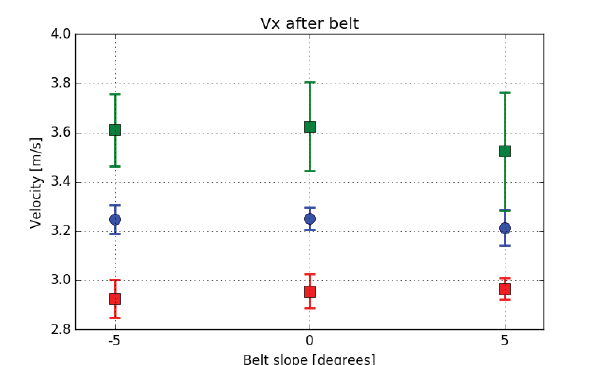
Figure 5. Results for inclining the belt. Here we show the mean values for V x maximum (upper squares), mean (discs), and min- imum (bottom squares) averaged in time for 3 belt slope angles. Angles are measured clockwise and 0 means the base state were belt is